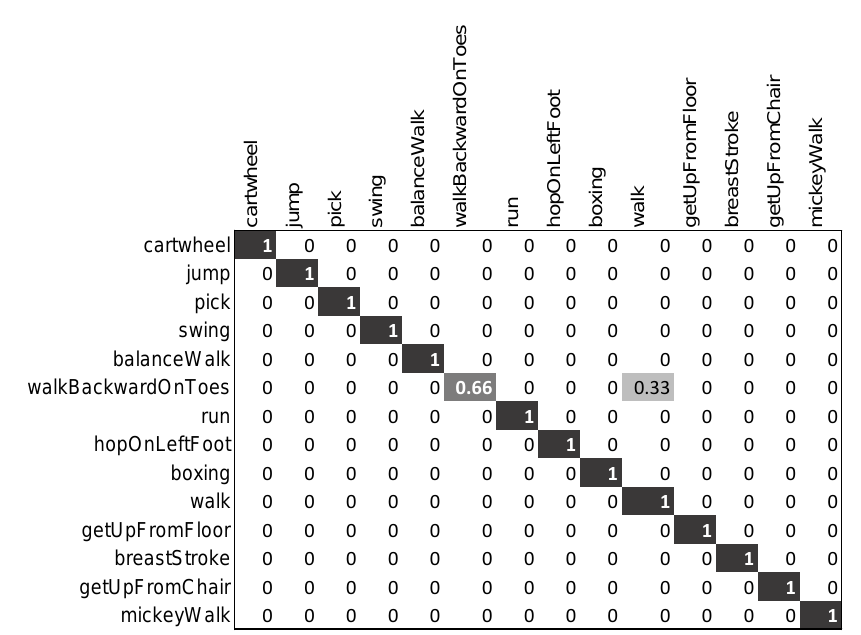
Figure 9. Confusion matrix of our proposed approach on the CMU-14